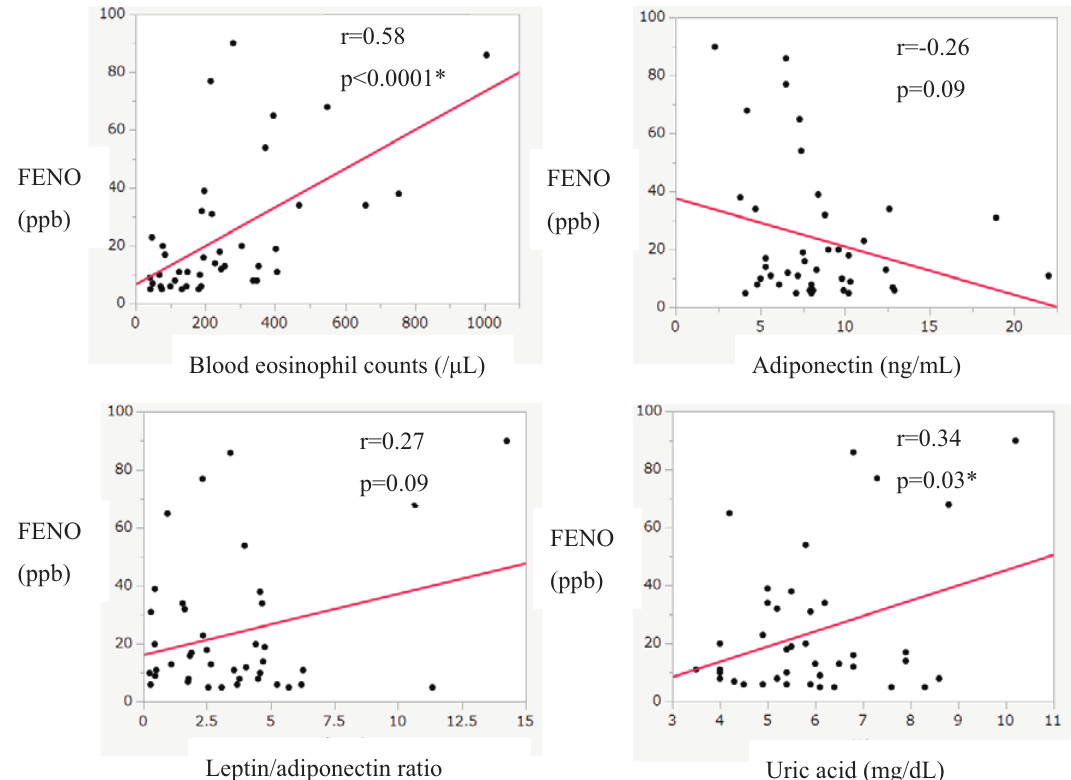
Fi g ure 2 Scatter plots ill u stratin g u ni v ariate correlations bet w een FENO and explanator y v ariables. FENO, fractional exhaled nitric